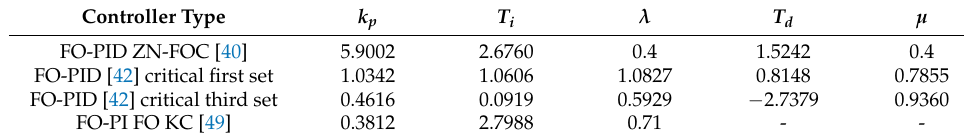
Table 7. Closed-loop results obtained with the FO-PID controller for the integrative time-delay pro- cess. Table 6. FO-PID parameters computed for the integrative time-delay process.